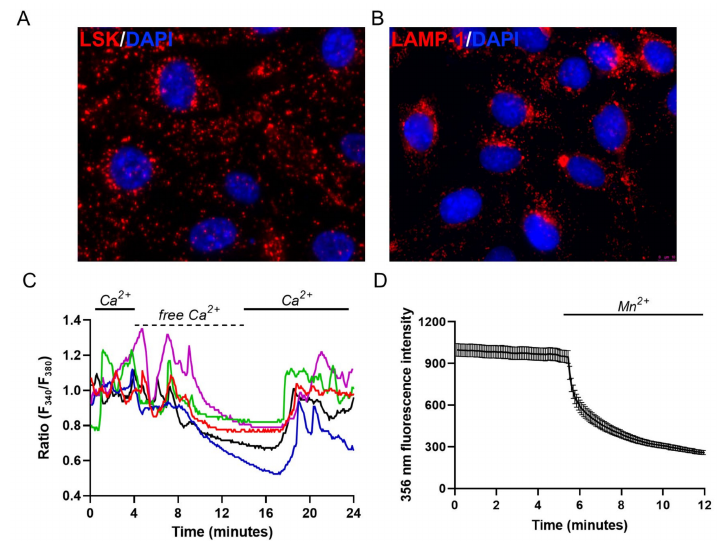
Figure 1. Endo-lysosomal system distribution and Ca 2+ signaling events in M1 cells. ( A ) Repre- sentative merged epifluorescence acquisition of live M1 cells loaded with LSK (red) to stain acidic organelles and stained with DAPI (blue) to mark the nucleus; ( B ) Representative epifluorescence image of the lysosomal marker LAMP-1 (red) merged with DAPI (blue); ( C ) Ca 2+ oscillations of 5 representative Fura-2-loaded M1 cells ( n = 102/102 responsive cells, m = 3 experiments) in the presence (Ca 2+ 1.2 mM, full lines) or in the absence of extracellular Ca 2+ (free Ca 2+ , dotted line). Each color line represents an individual cell; ( D ) Quenching of Fura-2 after addition of 0.5 mM Mn 2+ in the absence of extracellular Ca 2+ at its isosbestic point. The reported values are means ± SEM from all the responsive cells on a single coverslip ( n = 123/123 responsive cells, m = 3